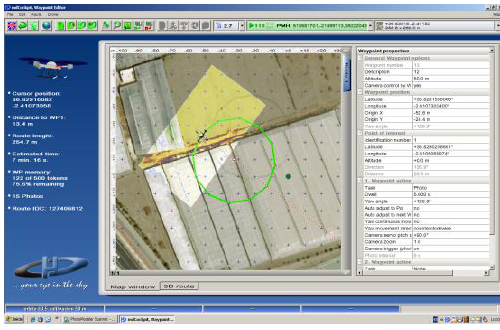
Figure 2. Flight planning with MdCockpit V2.6.2.6